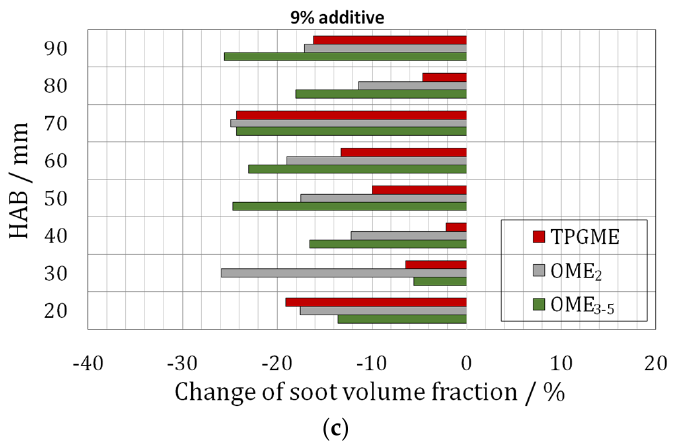
Figure 8. Comparison of f V change between TPGME, OME 2 and OME 3–5 diesel blends with respect to the baseline with ( a ) 1% of additives, ( b ) 3% of additives and ( c ) 9% of additives.